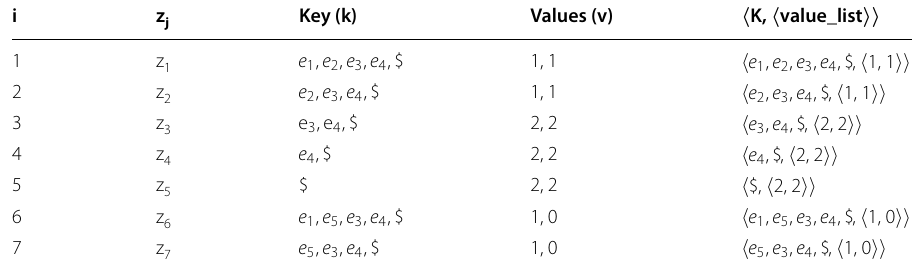
Table 6 Result of merging of intermediate key/value pairs by Map-Reduce framework